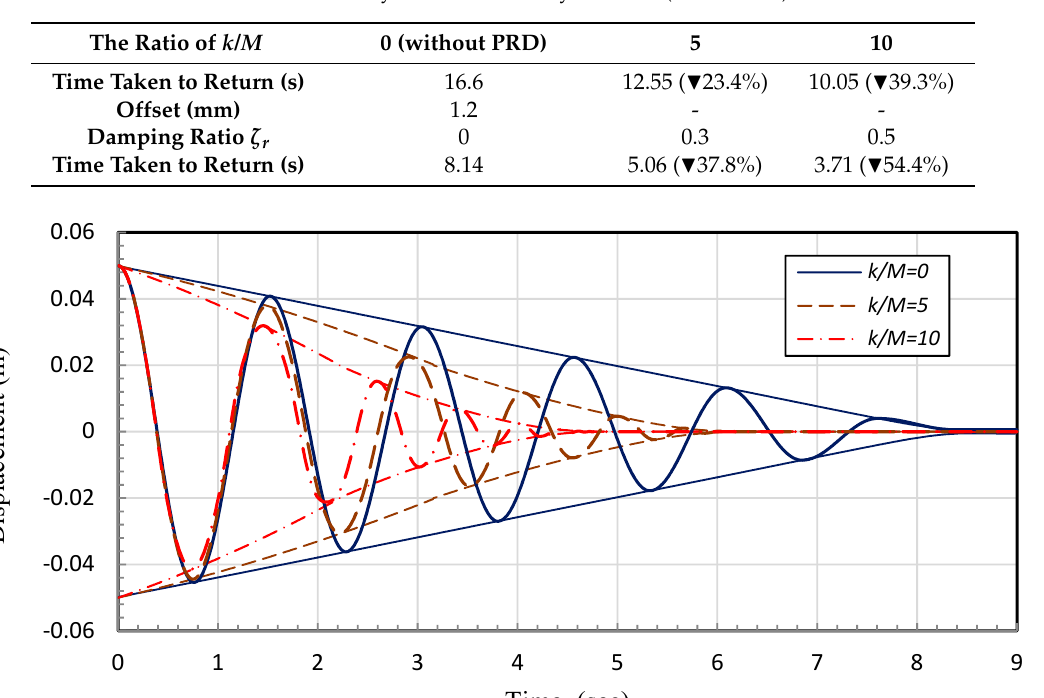
Figure 4. Transient responses of the superstructure according to change of ς r in case of k / M = 5. Table 2. Summary of transient analysis result ( (cid:72) : Decease).